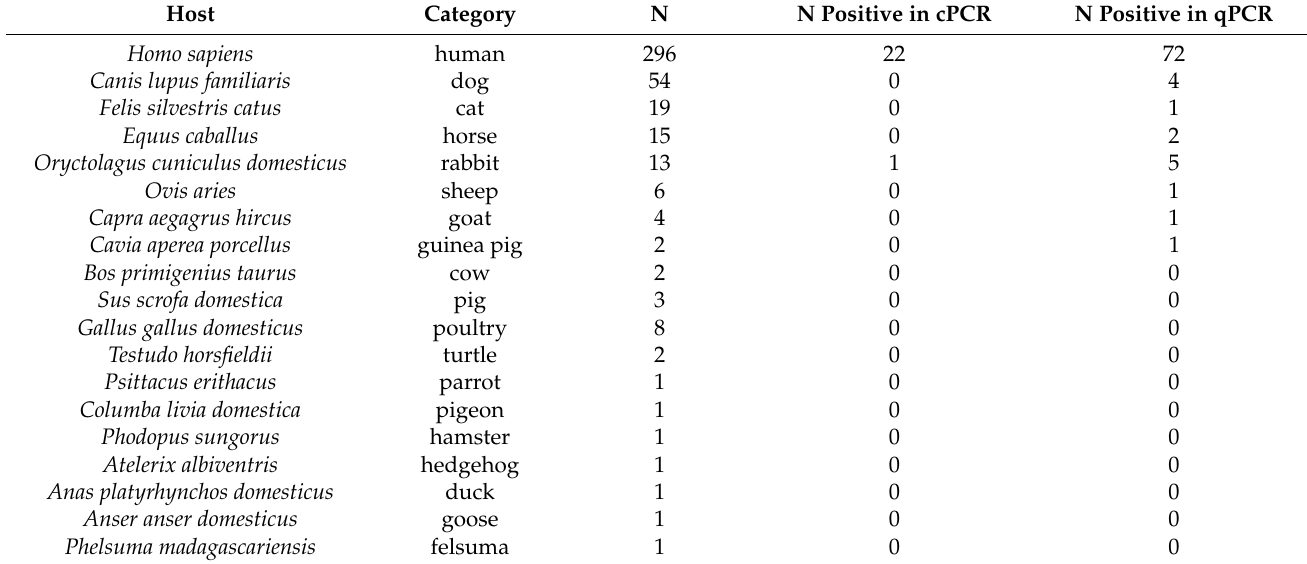
Table 1. List of human and animal species included in this study and the number of positive Dientamoeba fragilis samples for each species. (N—number of samples; cPCR—conventional PCR; qPCR—real-time